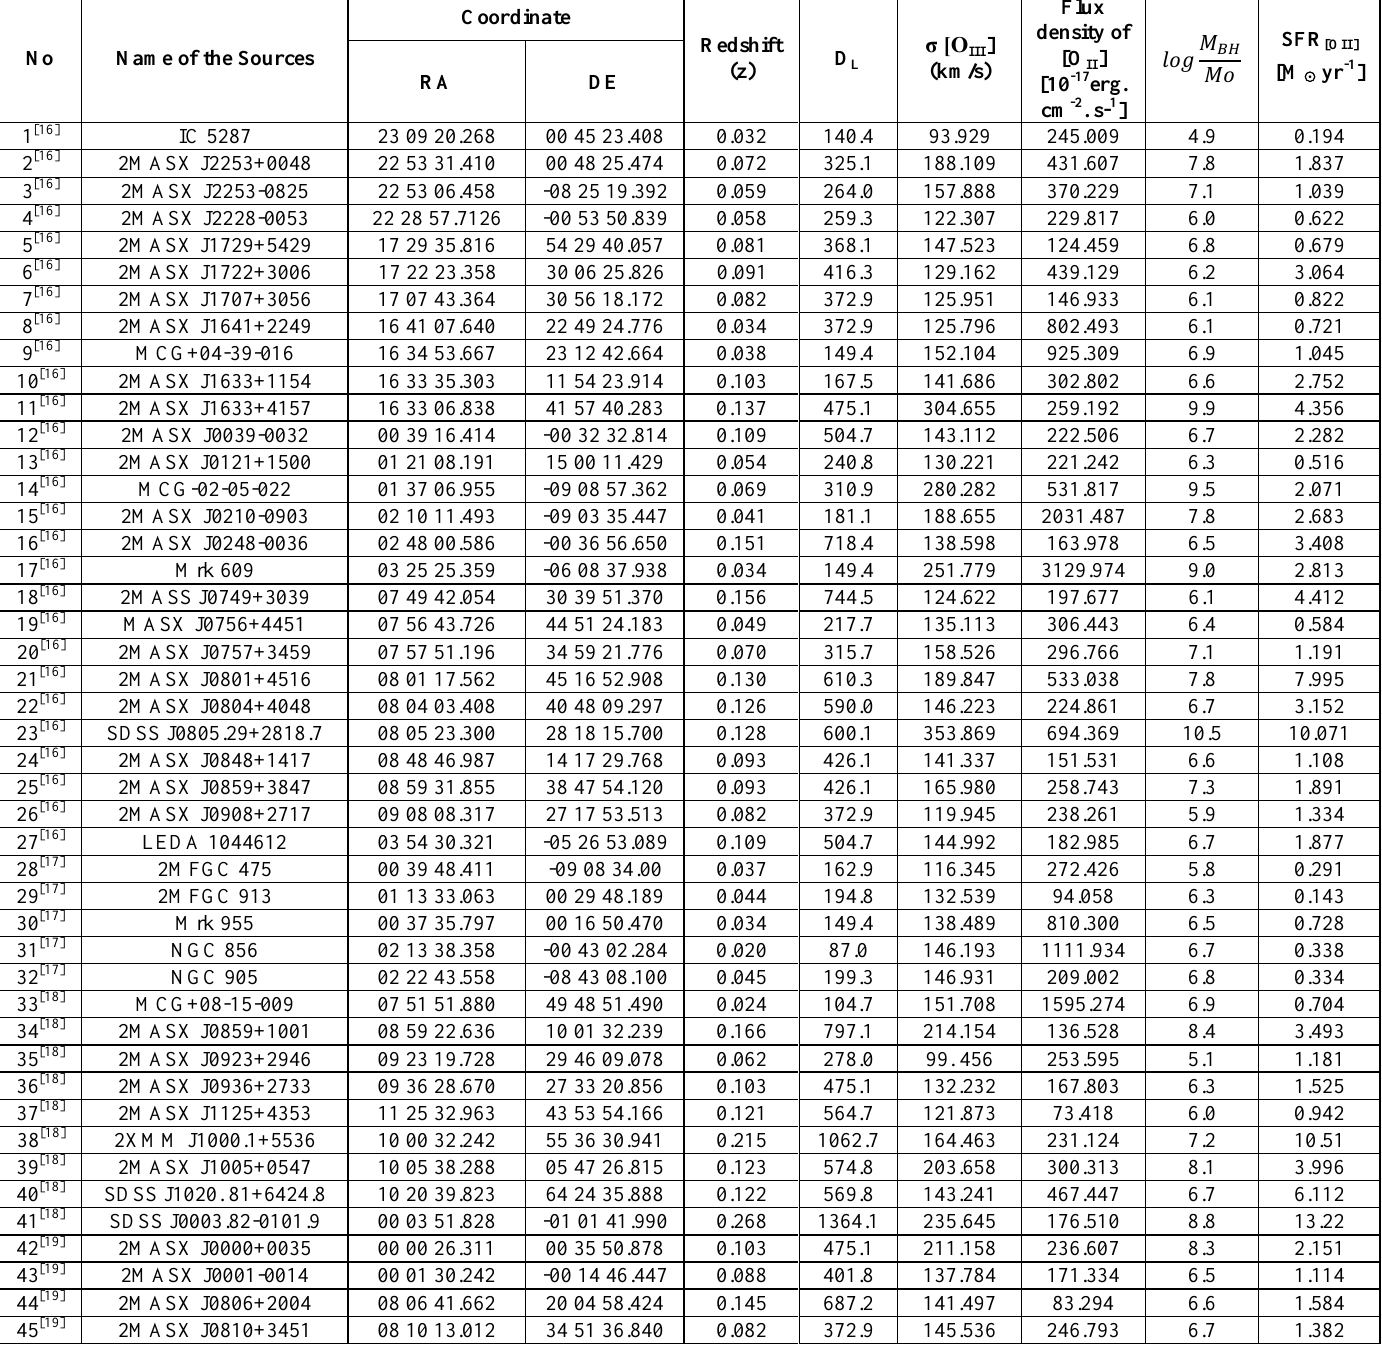
Table 2: The data for Sy2